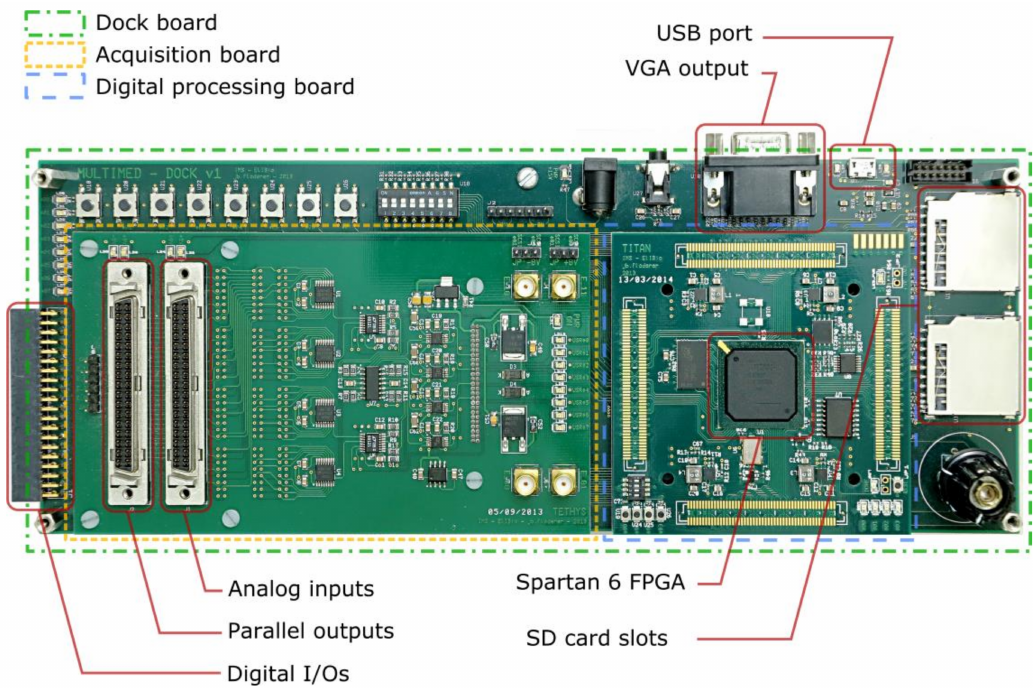
Figure 2. The Multimed system and its hardware